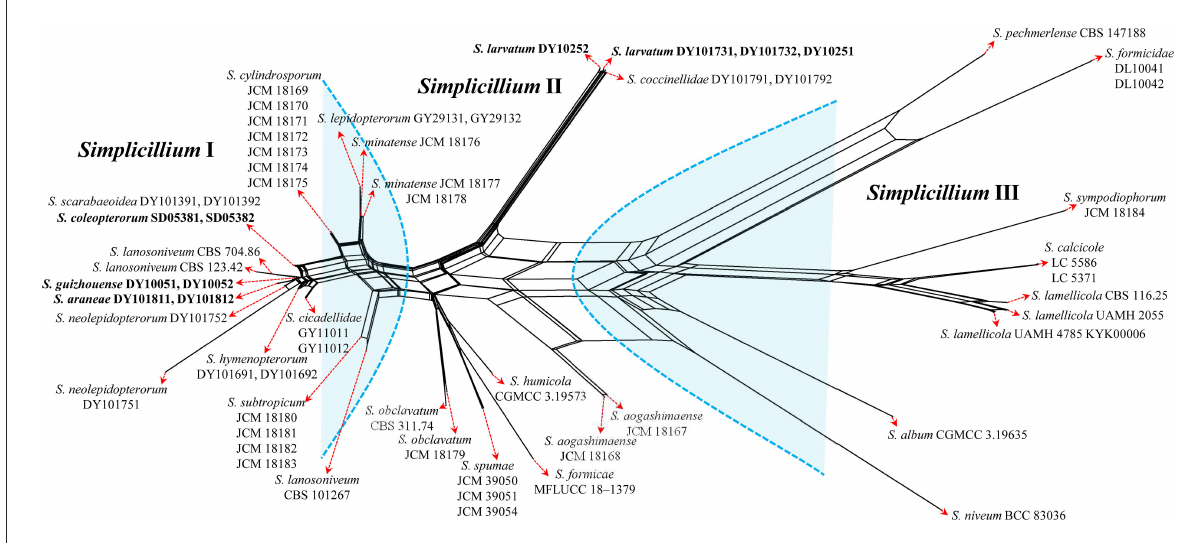
FIGURE3 Reconstruction of the neighbor-net network based on ITS sequences from taxa in Figure